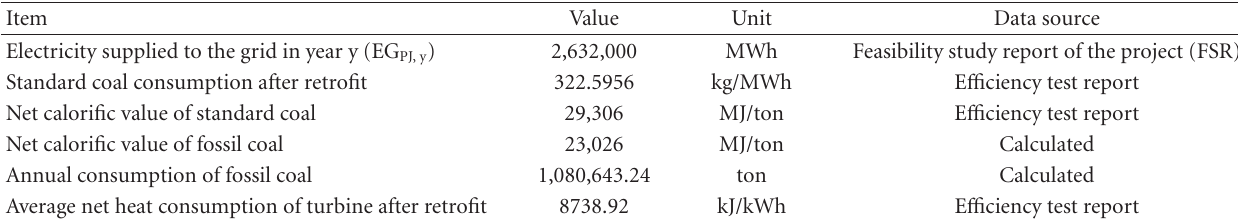
Table 2: The key parameters of the